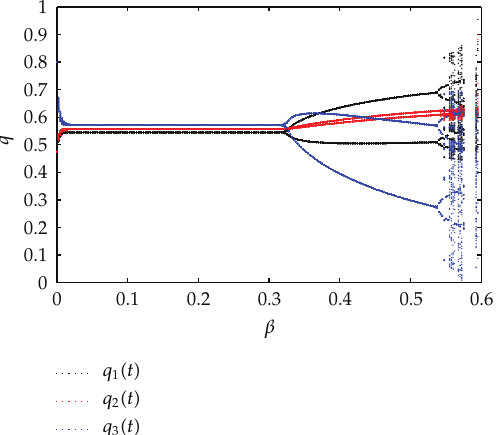
Figure 5: Bifurcation with α (cid:7) − 0 . 1, β ∈ (cid:5) 0 , 0 . 6 (cid:6) .